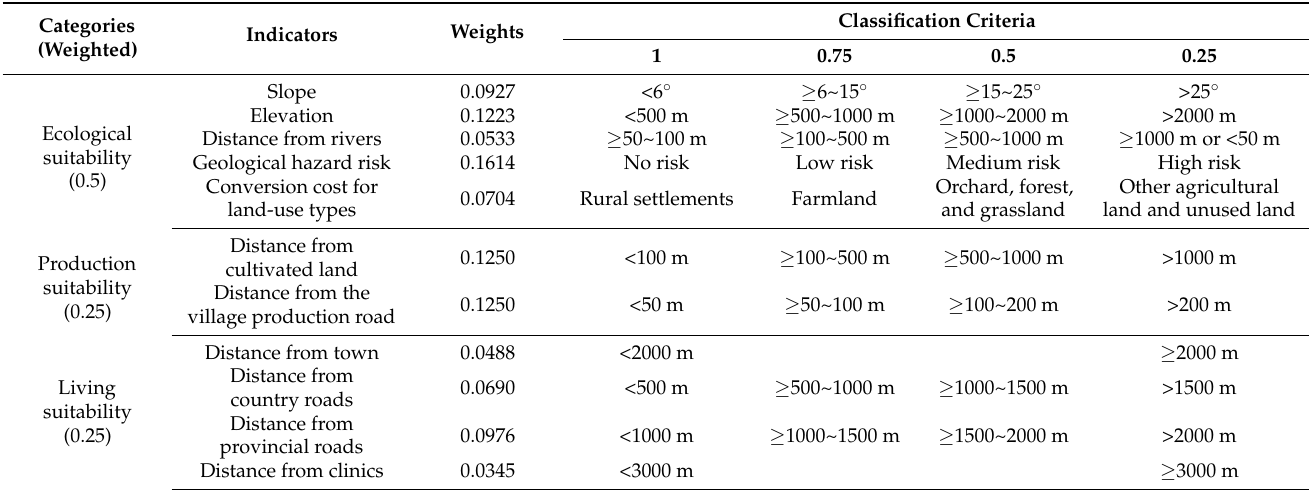
Table 3. Index system of suitability evaluation of rural settlement